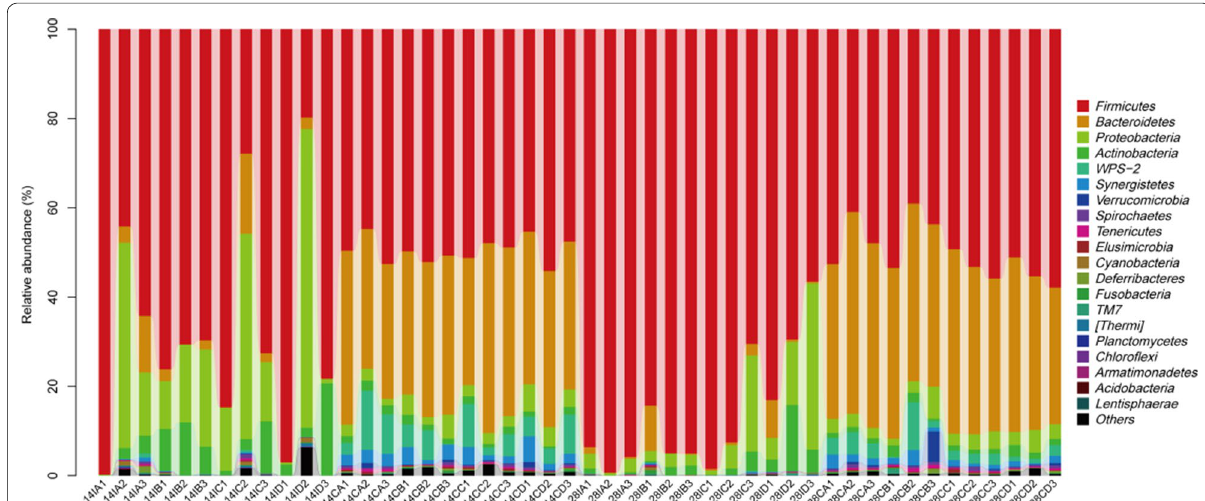
Fig. 5 The phylum level distribution of ileal and cecal microbiota among groups. 14IA: 14‑d ileum control group; 14IB: 14‑d ileum Astragalus group; 14IC: 14‑d ileum L. plantarum group; 14ID: 14‑d ileum fermented Astragalus group; 14CA: 14‑d cecum control group; 14CB: 14‑d cecum Astragalus group; 14CC: 14‑d cecum L. plantarum group; 14CD: 14‑d cecum fermented Astragalus group; 28IA: 28‑d ileum control group; 28IB: 28‑d ileum Astragalus group; 28IC: 28‑d ileum L. plantarum group; 28ID: 28‑d ileum fermented Astragalus group; 28CA: 28‑d cecum control group; 28CB: 28‑d cecum Astragalus group; 28CC: 28‑d cecum L. plantarum group; 28CD: 28‑d cecum fermented Astragalus group